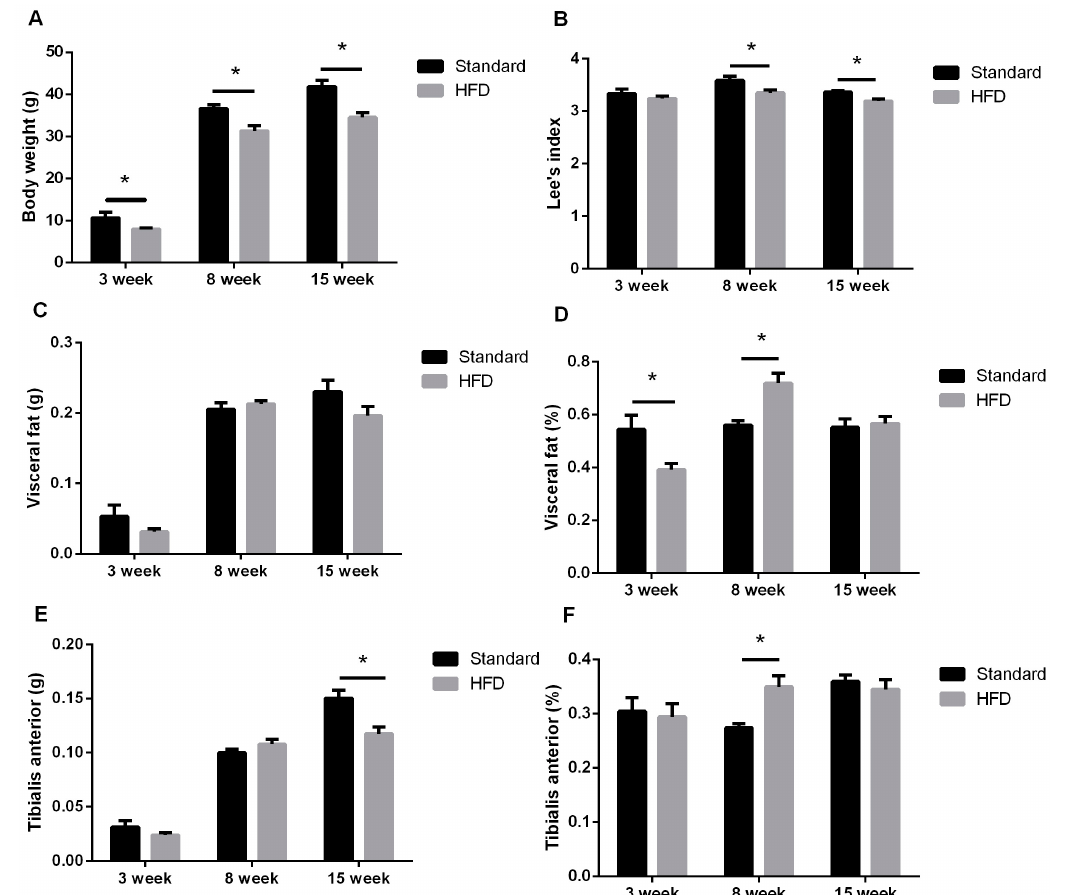
Figure 3. Exposure to maternal high-fat diet resulted in retarded growth in male offspring. Body weights ( A ), Lee’ index ( B ), visceral fat weights ( C ), visceral fat relative weights ( D ), tibialis anterior weights ( E ) and tibialis anterior relative weights ( F ) have been shown. Lee’s index = [(Body weight (g) × 1000) 1/3 ]/Body length (cm); it is an indicator of mouse growth and adiposity. n = 10, * indicates p < 0.05.